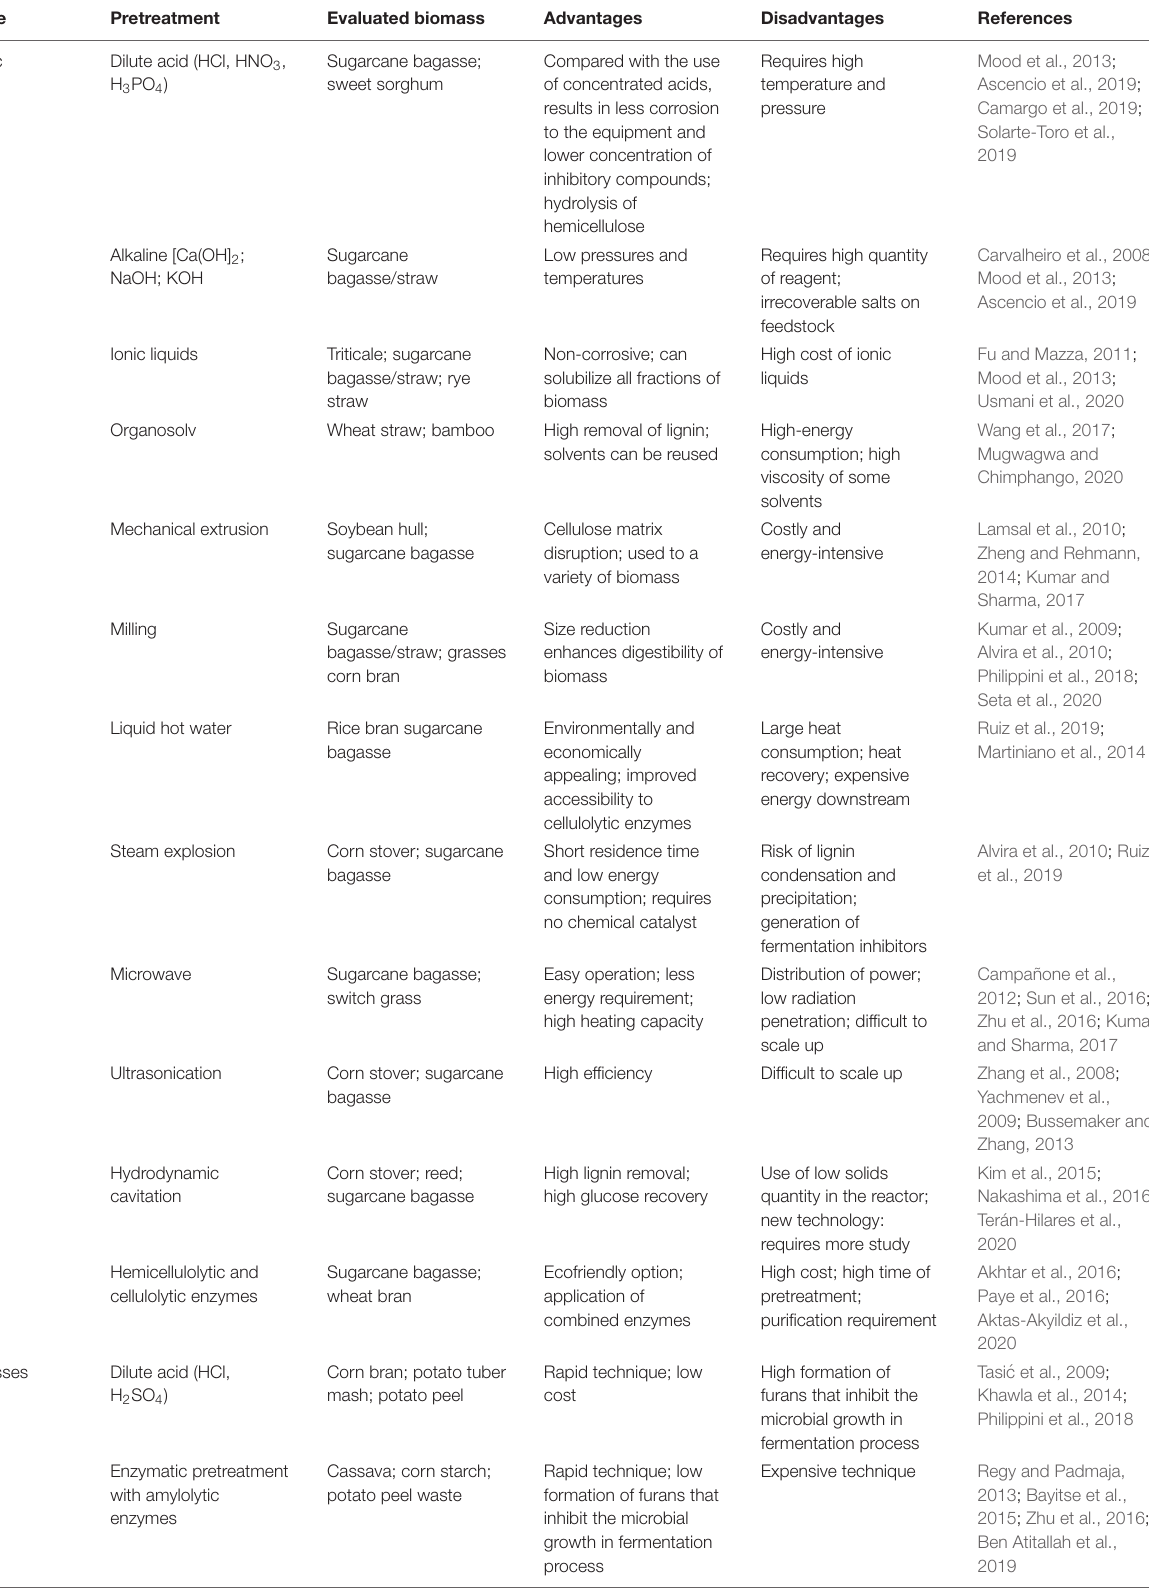
TABLE 1 | Most relevant pretreatments on different lignocellulosic and starchy